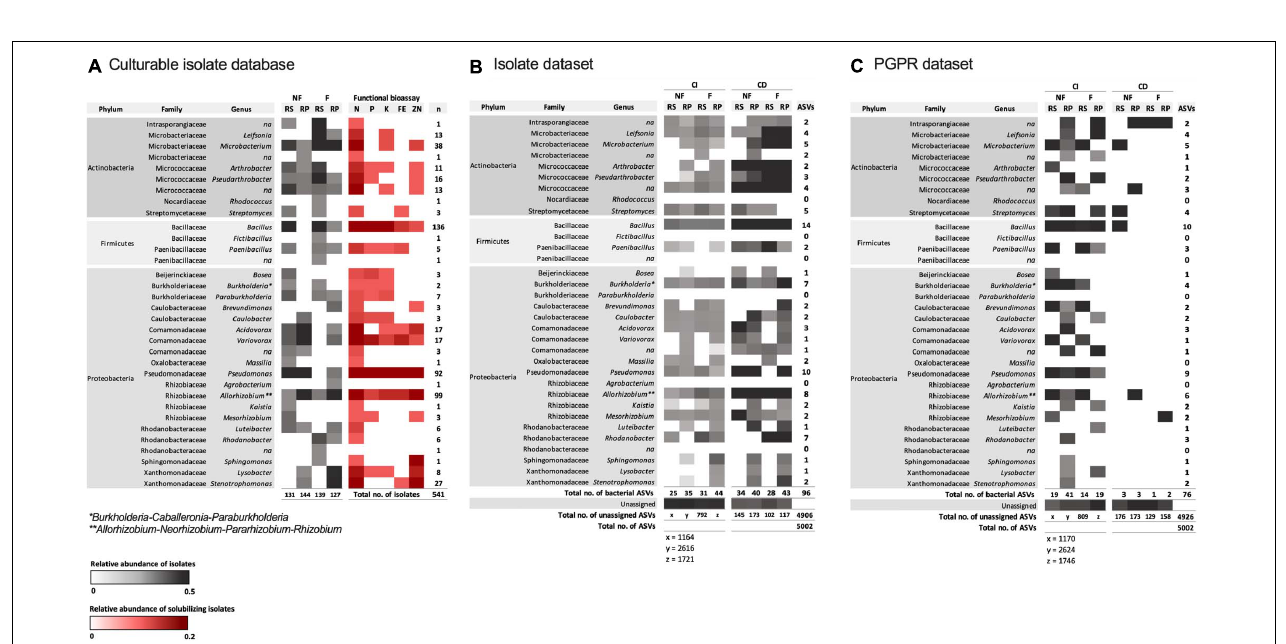
FIGURE 6 | Heatmaps representing abundance and associated functional ability of bacterial isolates from rhizosphere (RS) and rhizoplane (RP) samples from non-fertilized (NF) and fertilized (F) wheat. (A) The full region of the 16S rRNA gene was amplified and sequenced for each rhizobacterial isolate. Identifications are based on the SILVA database for prokaryotes. Gray indicates relative abundance of genera in each sample (number of isolates per sample shown below columns). Red indicates relative abundance of positively solubilizing isolates from total number of isolates sequenced (541). “ n ” shows number of genera identified from total number of isolates sequenced. (B) All culturable rhizobacterial isolate sequences and (C) plant growth-promoting rhizobacteria (PGPR) isolate sequences were used to create a database with which the culture-independent (CI) and culture-dependent (CD) amplicon datasets were searched against using blast at 100% sequence identity. Burkholderia* stands for Burkholderia-Caballeronia-Paraburkholderia; Allorhizobium** stands for Allorhizobium-Neorhizobium-Pararhizobium-Rhizobium.